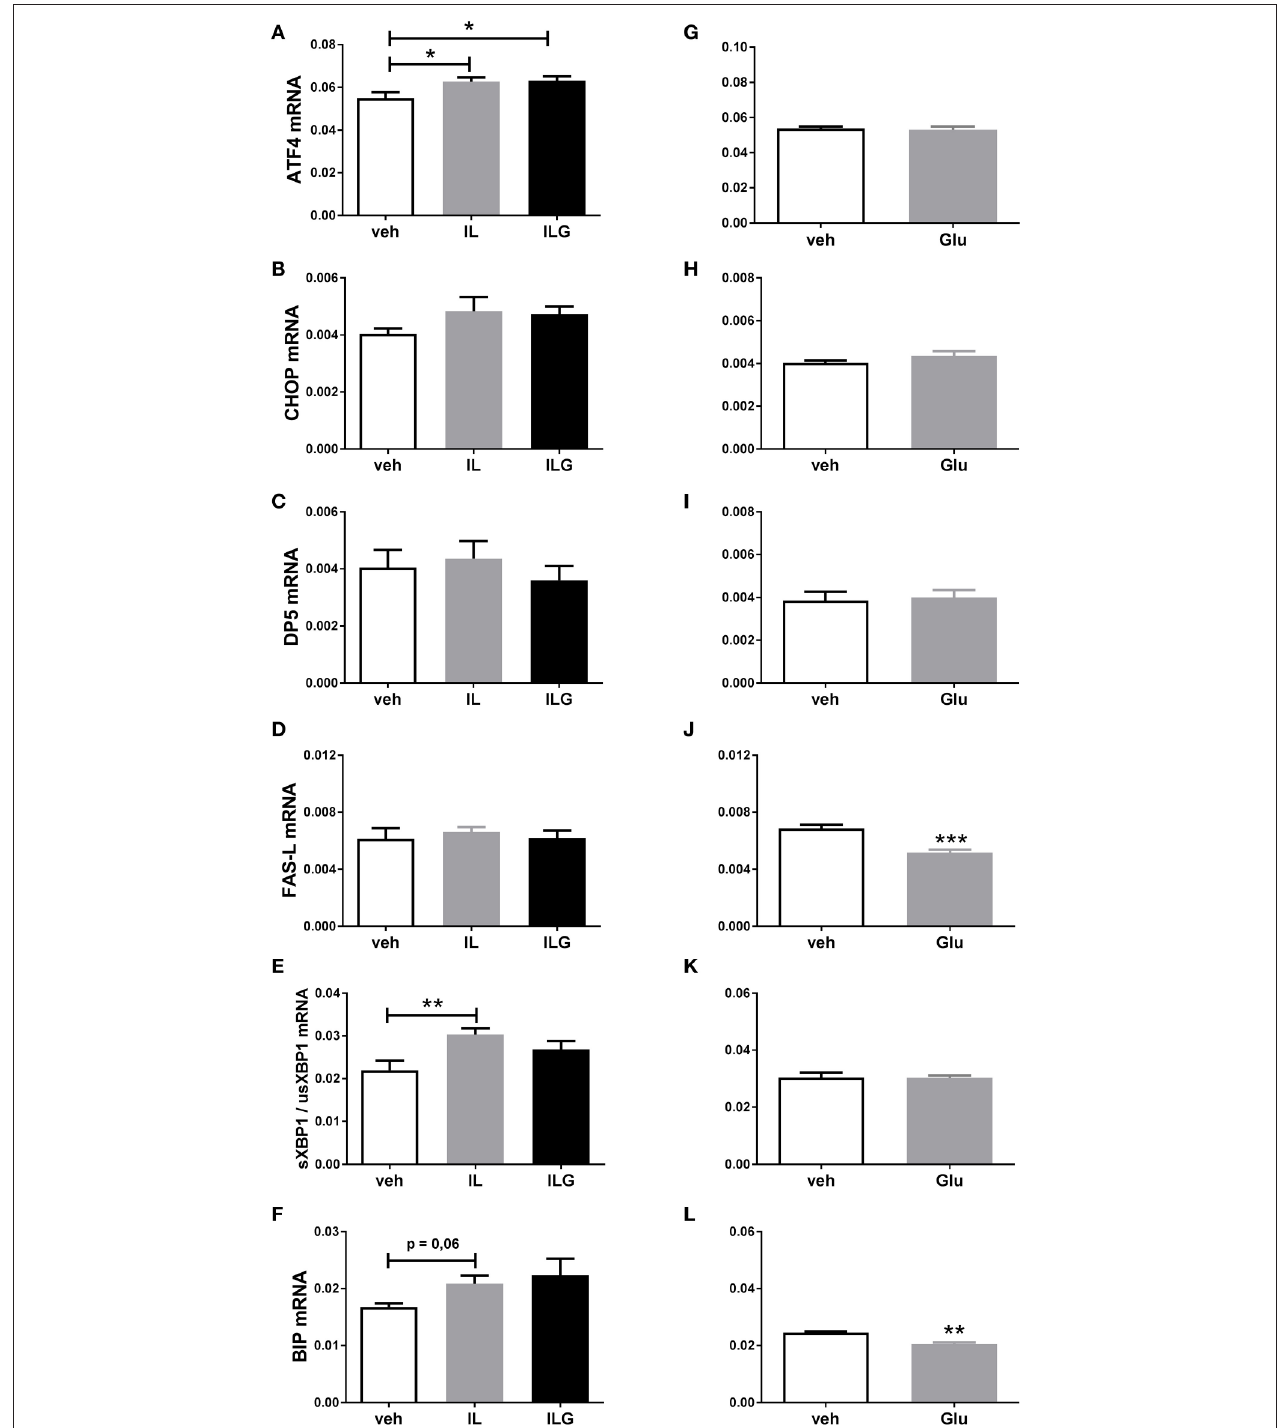
FIGURE 3 | The effect of central infusion of Intralipid (IL), Intralipid and Glucose (ILG) or Glucose on hypothalamic (A,G) ATF4, (B,H) CHOP (C) , (C,I) DP5, (D,J) FasL, (E,K) sXBP1/usXBP1, (F,L) Bip mRNA expression in chow rats . mRNA expression of specific genes was normalized to the geometric mean of three housekeeping genes. Significant differences between groups: * p < 0.05, ** p ≤ 0.01; *** p < 0.001.